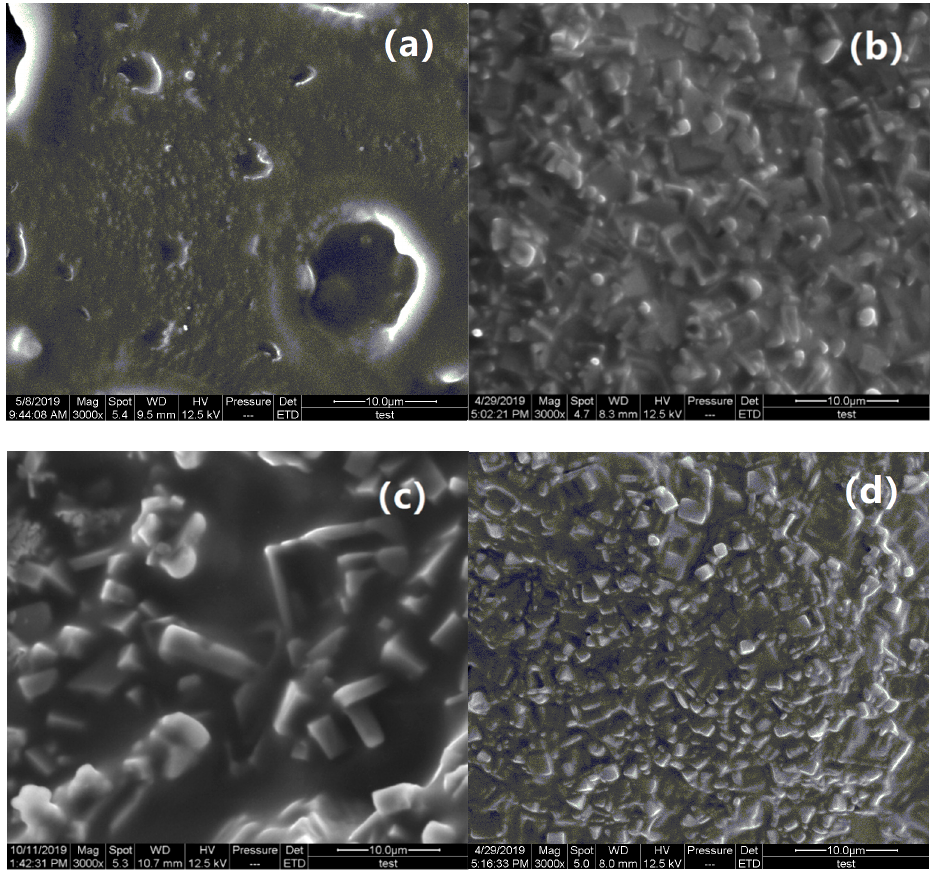
Figure 4. SEM images of ( a ) PVA gel, ( b ) Tb fluorescent gel, ( c ) Eu fluorescent gel, and ( d ) Eu/Tb fluorescent gel. Table 1. Energy-dispersive X-ray-spectroscopy results for Tb/Eu fluorescent gel. Element wt.% at. %